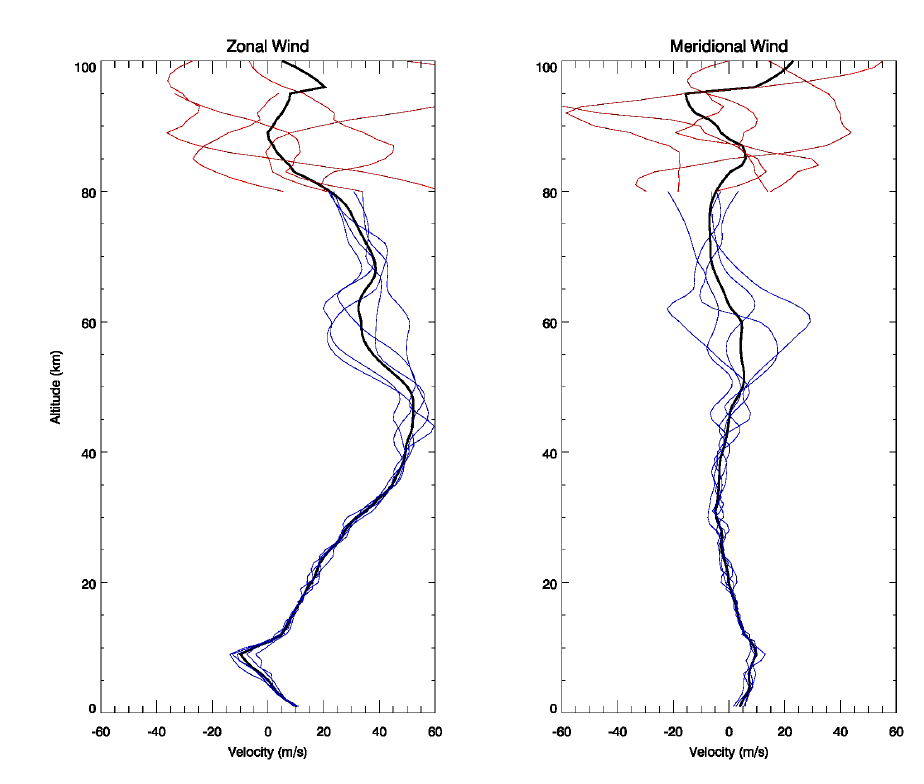
Figure 4. Individual 3-hourly (18, 21, 00, 03 and 06 UT) winds from ERA-5 reanalysis (blue) and KSS meteor radar measurements (red), and the averaged night time wind profile